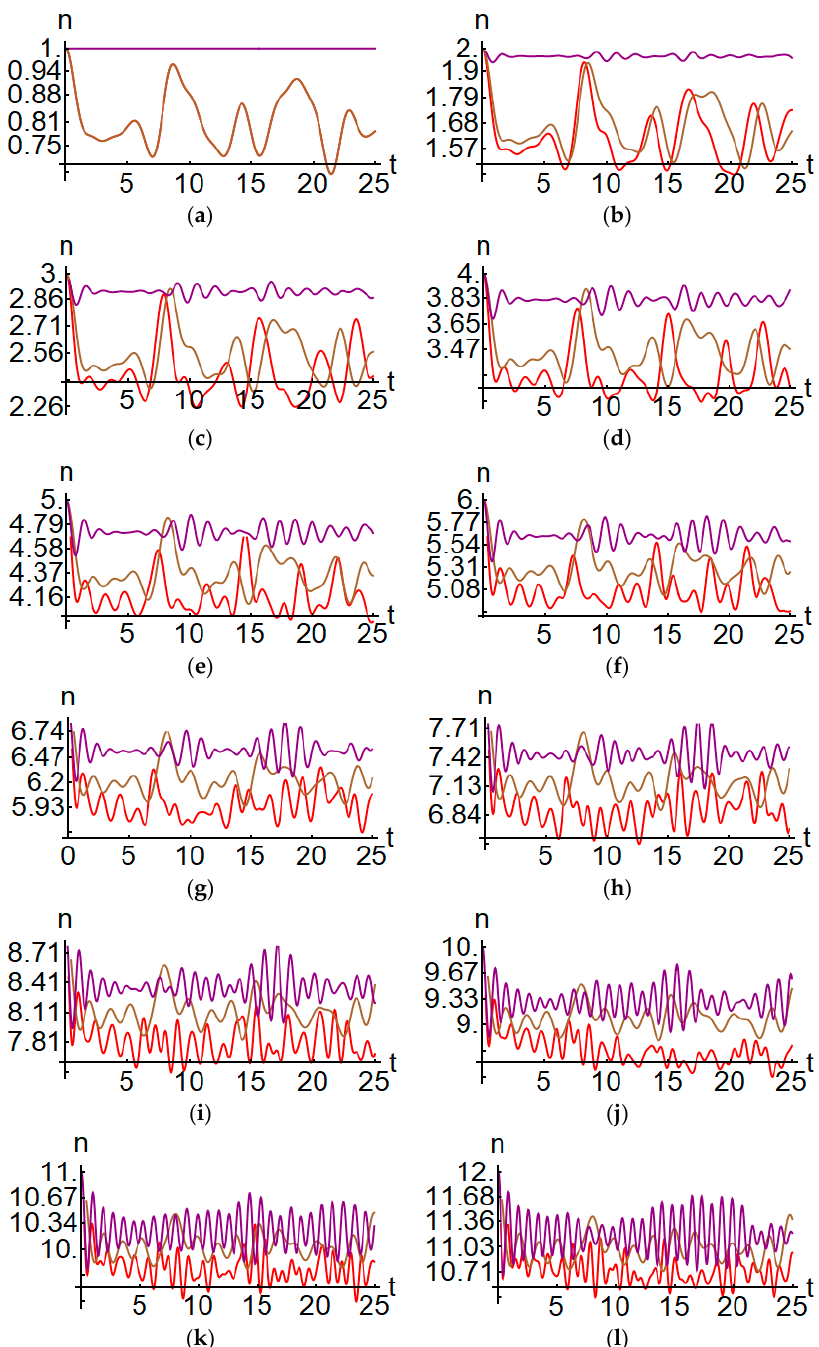
Figure 8. The number of photons, n, in the system at time t during the evolution of the system is shown. The first spin of the system interacts with the electromagnetic field. Purple, brown, and red correspond to cases where there is only two-photon absorption, only one-photon absorption, and absorption in both cases, respectively. ( a ) corresponds to 1 photon, ( b ) corresponds to 2 photon, ( c ) corresponds to 3 photon, ( d ) corresponds to 4, ( e–l ) corresponds to 5–12 photon.